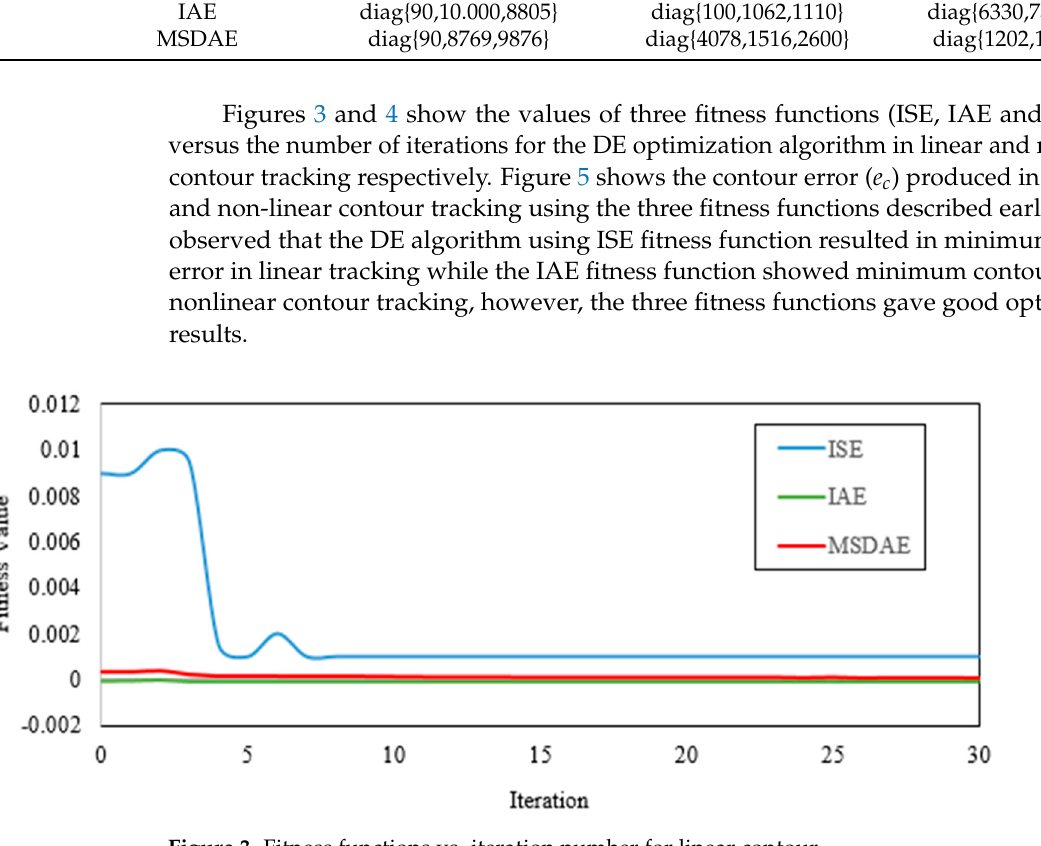
Figure 4. Fitness functions vs. iteration number for non-linear contour.